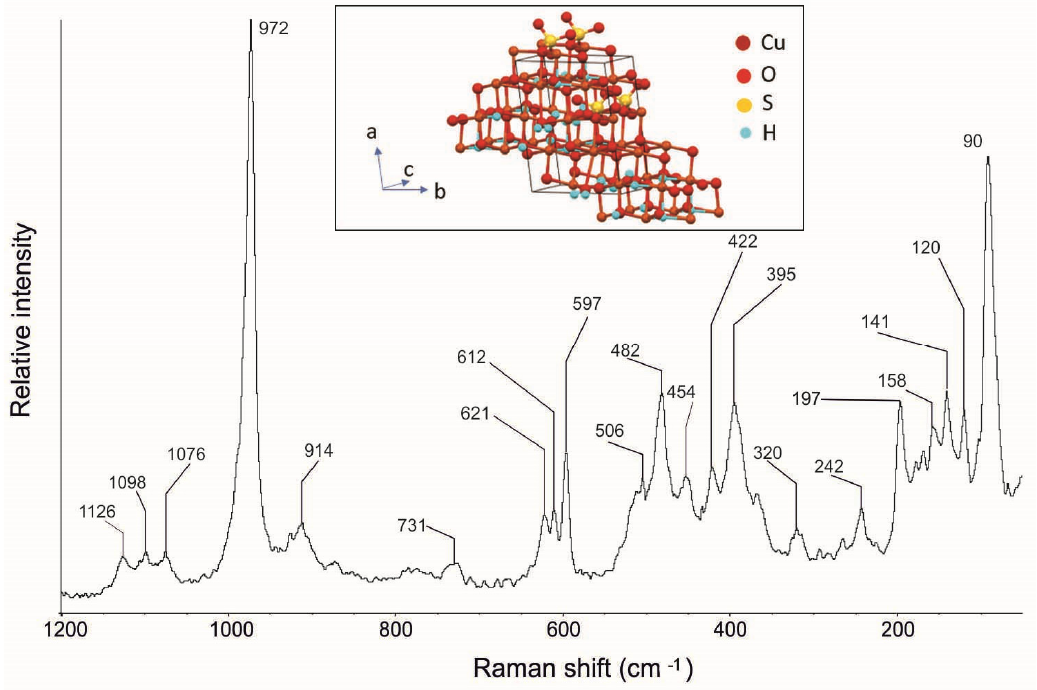
Figure 19. Raman spectra of posnjakite from the Mastricarro Barite Mine (Catanzaro, southern Italy). In the insert is the structure of the posnjakite [40].